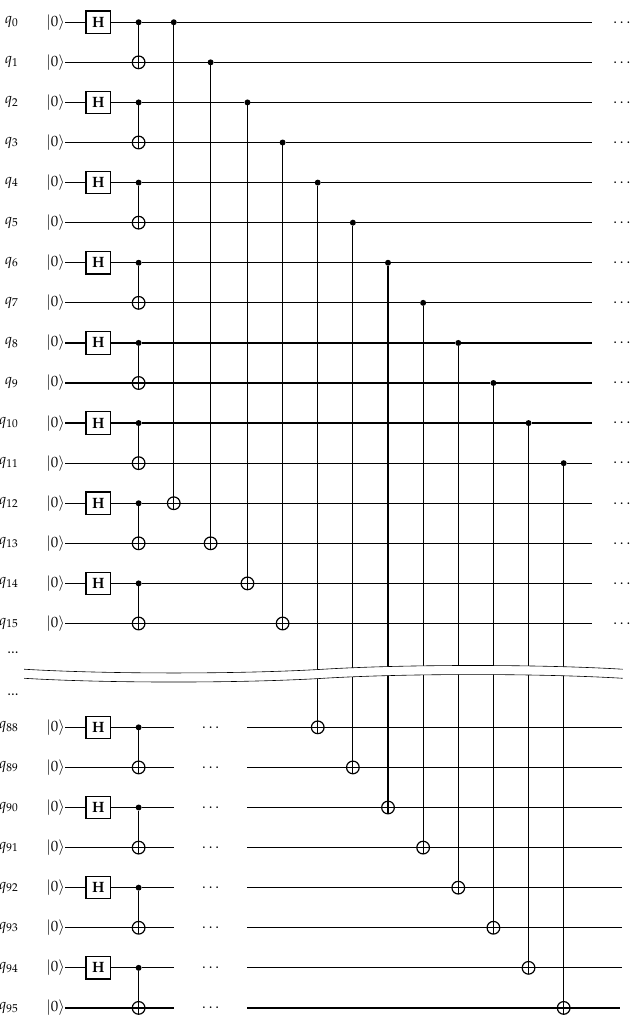
Figure 35. The global update circuit for the polyphonic musical example.